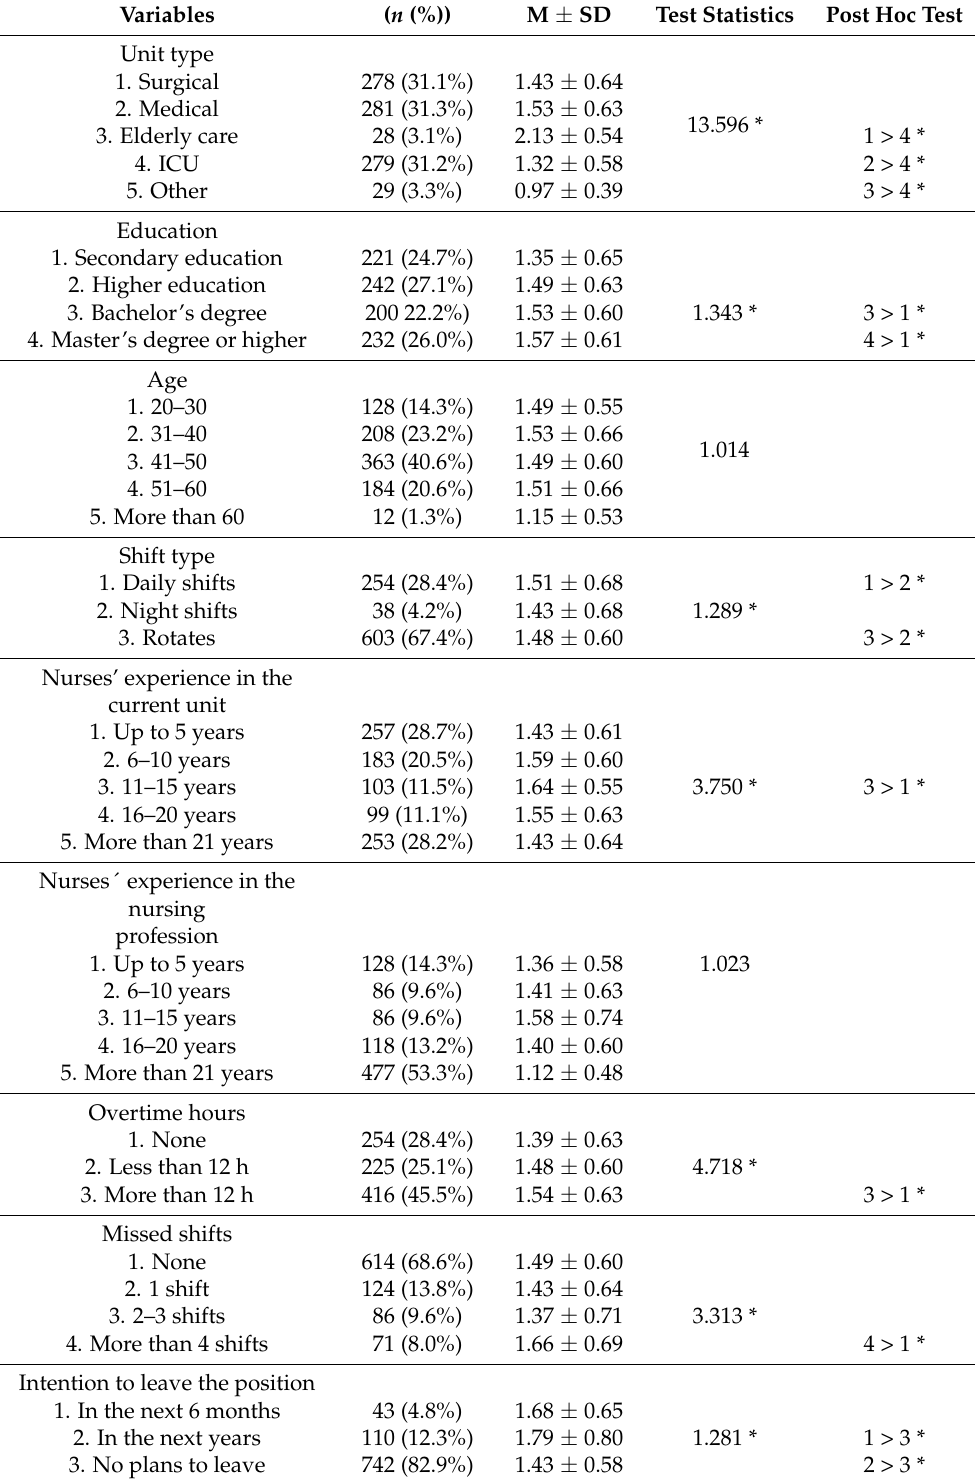
Table 2. Hospital, unit, and staff variables, and overall score (M) and standard deviations (SD) (scale range 0–4) for rationed nursing care ( N =